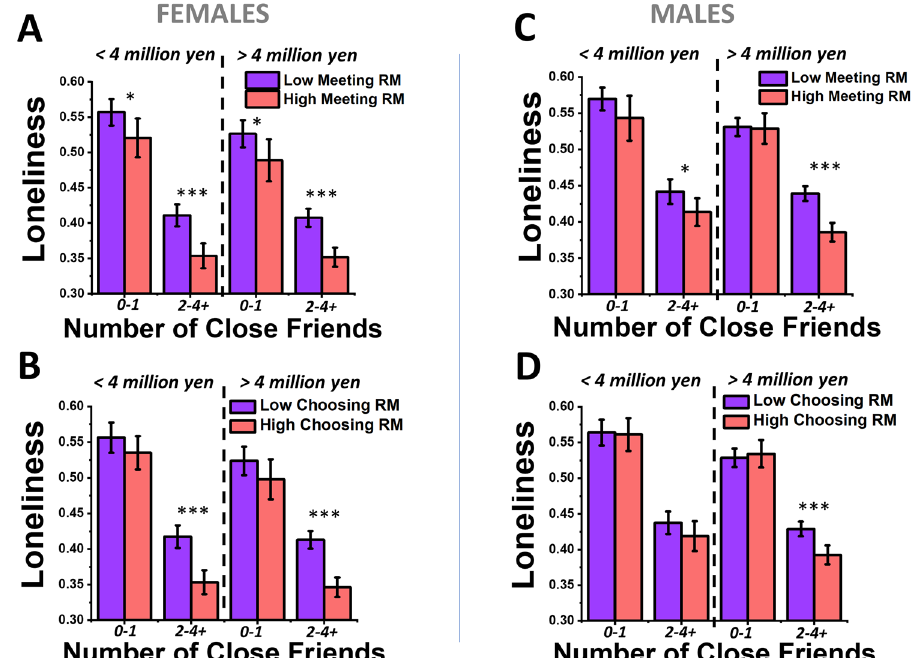
Figure 5. Summary of how perceptions of relational mobility correlate with loneliness when controlling for both number of close friends and income. Bar plots are presented showing the mean loneliness for major sub-populations that have either less than or higher than four million yen of annual household income, and also either 0–1 close friends or 2–4+ close friends, and then further divided into subjects that have either lower (purple) or higher (salmon pink) perceptions of relational mobility than the average relational mobility value reported across the entire survey sample. Within each bar plot, for each of the low/high income ranges plus low/ high number-of-close-friends categories, two-way ANOVA followed by Bonferroni-corrected pairwise tests were used to identify whether higher and lower relational mobility sub-groupings had significantly different means within each sub-population. For the pairwise tests within each number of close friends and income sub-population, labels were: * p < 0.05, ** p < 0.01, ***, p < 0.001. Loneliness scores are the continuous raw scores normalized by the max value of 30. Error bars are 95% confidence